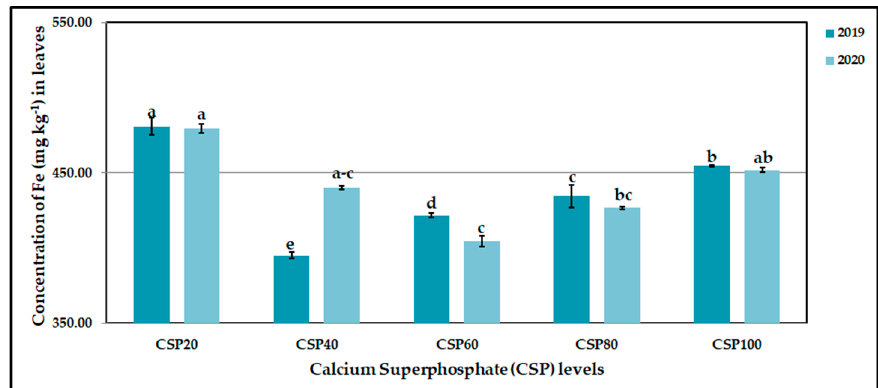
Figure 1. Influence of calcium superphosphate (CSP) levels on leaf iron (Fe, mg kg − 1 ) contents of CaCO 3 ‐ stressed sweet potato plants in 2019 and 2020 seasons. Bars with a different letter indicate significant difference between treatments at p ≤ 0.05. CSP 20 , CSP 40 , CSP 60 , CSP 80 , and CSP 100 represent CSP added as a soil application at 69, 138, 207, 276, and 345 kg ha − 1 , respectively.